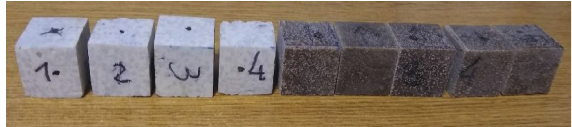
Figure 3: Samples for compression strength test. Formulation 1 samples with sandy color are in the right, and Formulation 2 samples with white color are in the